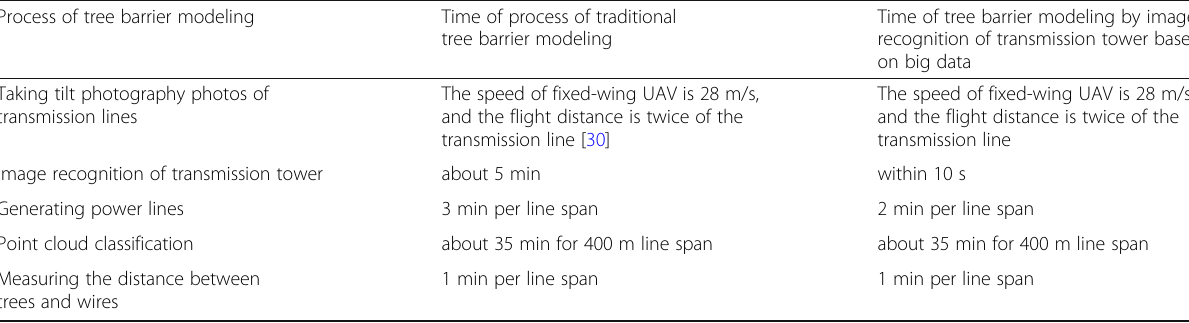
Table 4 Time comparison of process of traditional tree barrier modeling and tree barrier modeling proposed in this paper Process of tree barrier modeling Time of process of traditional Time of tree barrier modeling by image tree barrier modeling recognition of transmission tower